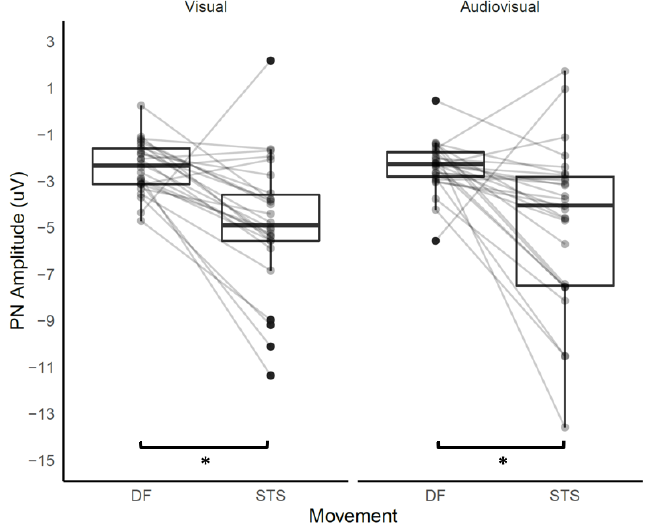
Figure 4. Box and whisker plots showing comparison of CNV PN amplitude during ankle dorsiflexion (DF) versus sit-to-stand (STS) movements, with visual and audio-visual cues. Individual datapoints are linked with light grey lines. * represents statistically significant differences ( p < 0.0001). Table 1. Descriptive statistics and pairwise comparisons for PN latency.